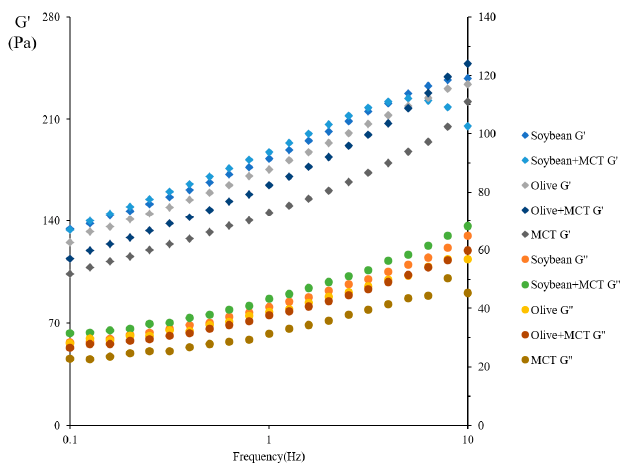
Figure 2. Effect of frequency on the G’ and G” values of the mayonnaise samples.